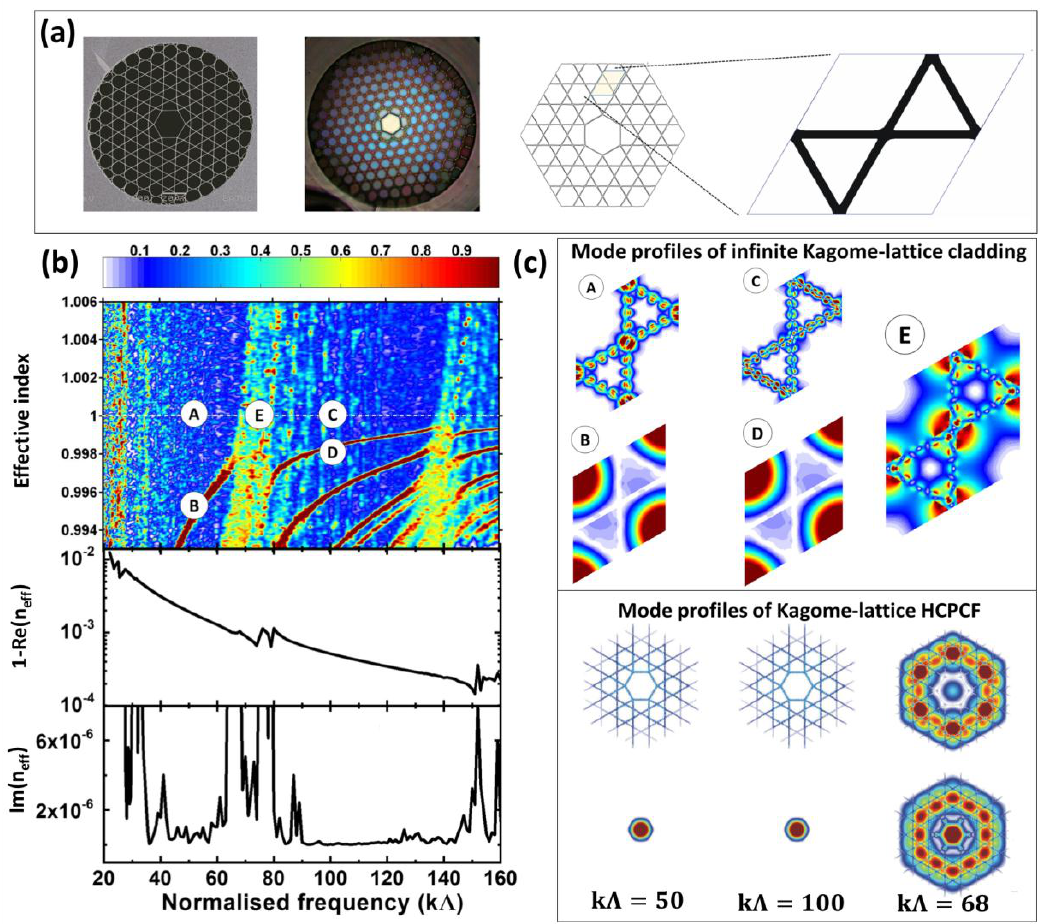
Figure 12. ( a ) Illustrations of Kagome lattice cladding HCPCF. ( b ) Calculated normalized DOPS diagram as a function of the real part of the effective index and normalized wavenumber. The two low DOPS intervals (blue colored regions) near the air light line n eff = 1 (white dashed line) correspond to band (I-noted A) and band (III-noted C). Band (II-noted E) corresponds to a strong anticrossing between a lattice-hole mode (relatively flat red curve) and a particular type of mode associated with the network of connected silica struts. ( c ) Nature of the Kagome lattice cladding modes. The first two columns show the core mode and a cladding mode, respectively, for a frequency k Λ = 50 in band I (top) and k Λ = 100 in band III (bottom). The third column shows the mode of an infinite Kagom é lattice (Reprinted with permission from Reference [4], Science,